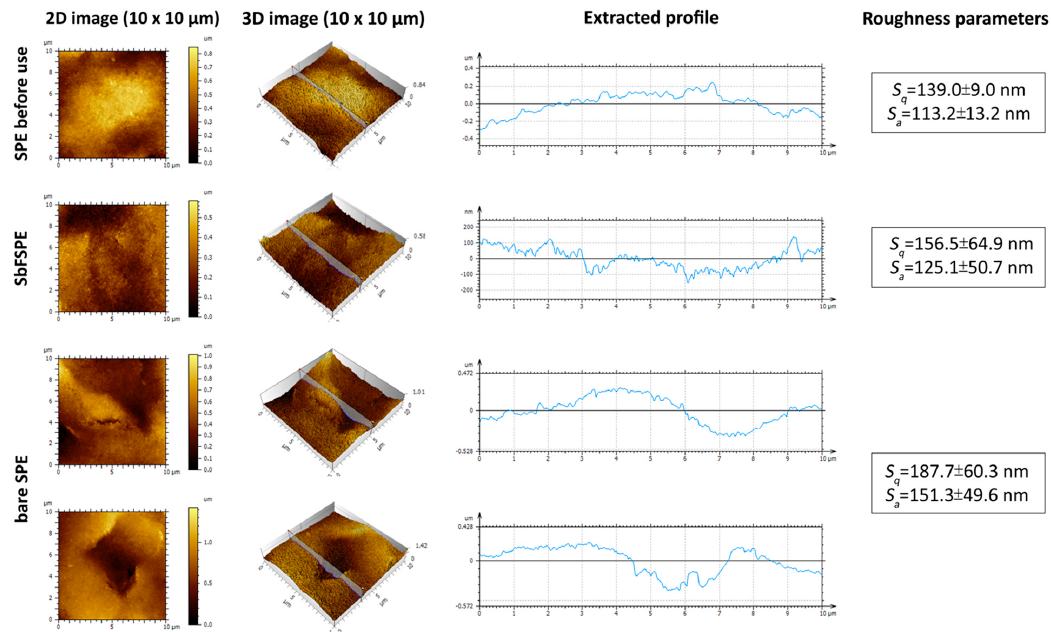
Figure 8. AFM images, extracted profiles, and roughness parameters of ( top row ) the SPE sensor before use, ( second row ) the SbFSPE sensor after five successive uses, and ( bottom two rows ) a bare SPE after same experimental conditions were employed as in Figure